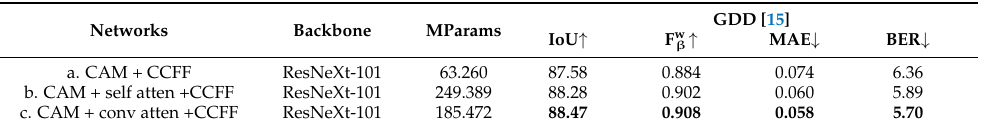
Table 5. Results of ablation experiments show that using convolutional attention in MFT can effec- tively reduce the number of parameters without loss of accuracy; “atten” indicates self-multi-headed attention, and “conv atten” indicates multiscale convolutional attention.